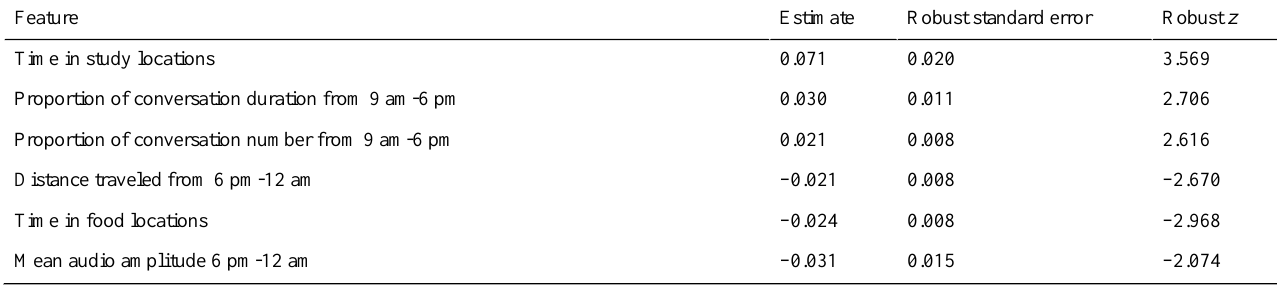
Robust z Robust standard